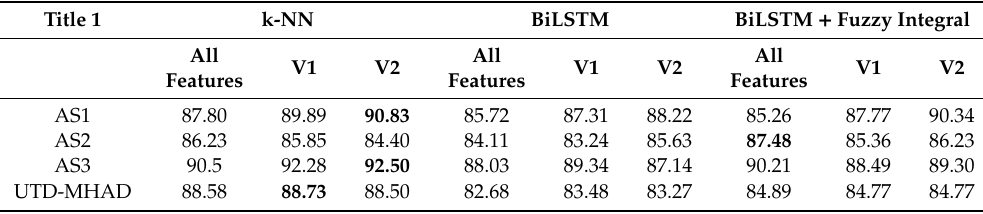
Table 16. Comparison of the best recognition rates [%] obtained by various methods (LOSO